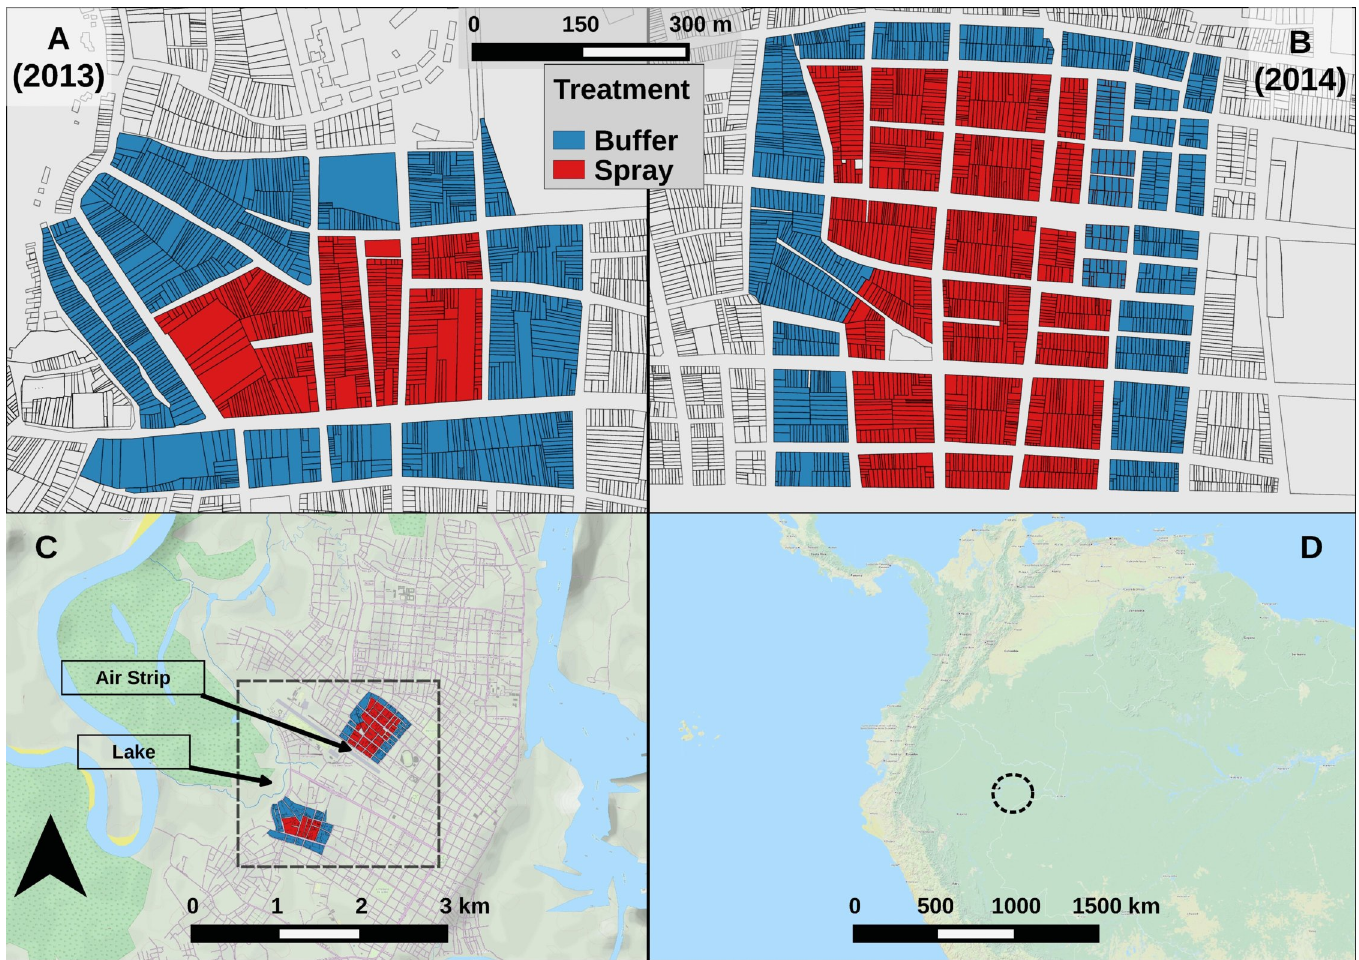
Fig 1. Map of experiment areas. Detail for (A) S-2013 and (B) L-2014 experimental areas, showing individual houses. Color shows sector. (C) City of Iquitos. Black box highlights experimental areas. (D) Regional map. Black circle highlights Iquitos. See also S6